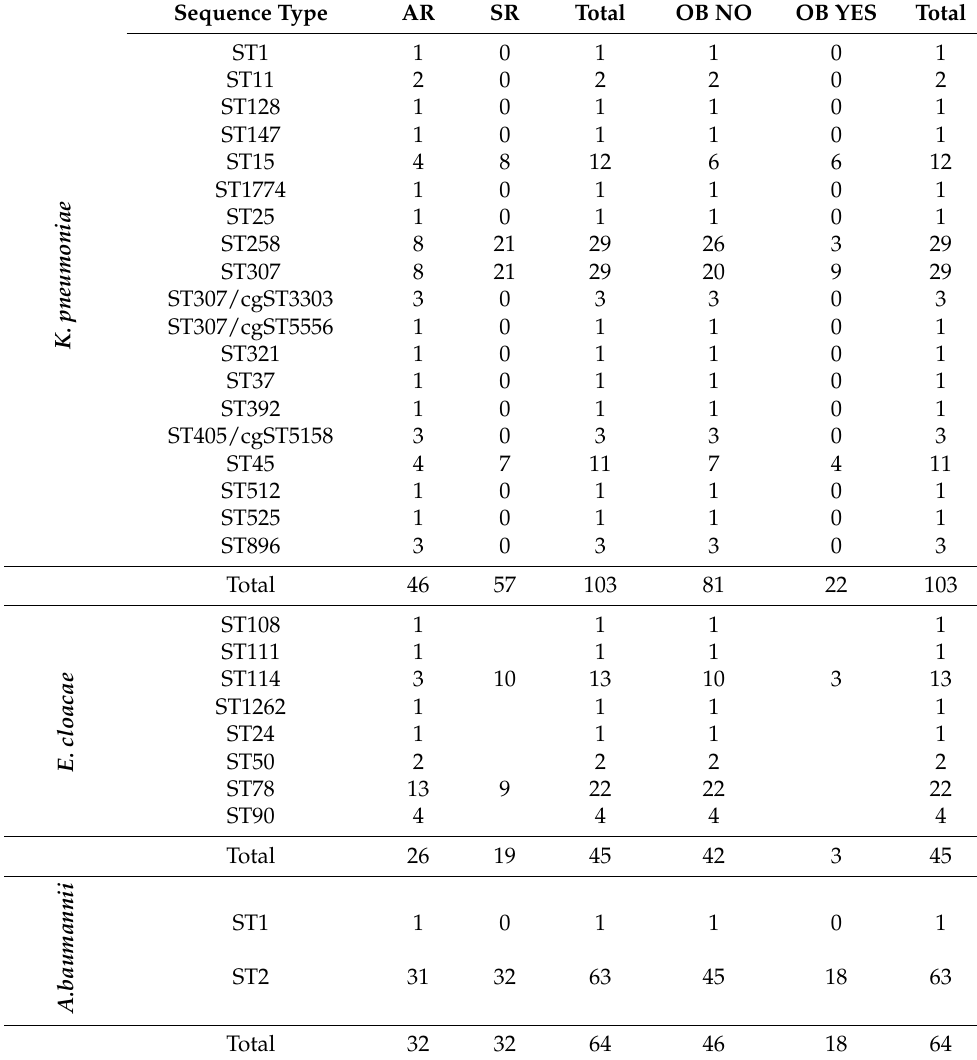
Table 4. Relationship between sequence types of each CPB, type of relationship, and involvement in a nosocomial